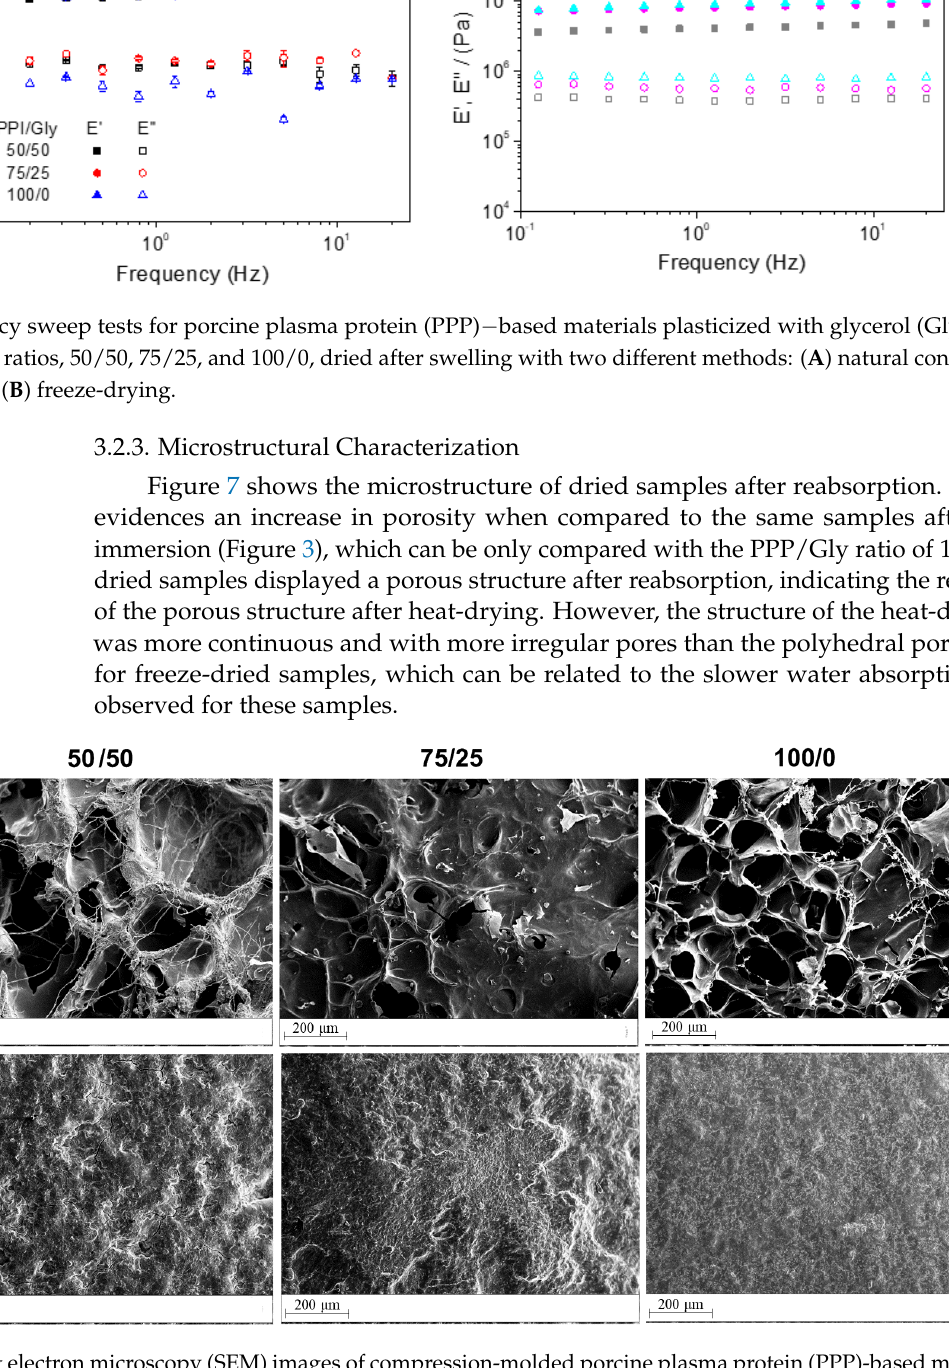
Figure 7. Scanning electron microscopy (SEM) images of compression-molded porcine plasma protein (PPP)-based materials plasticized with glycerol (Gly) with different PPP/Gly ratios, 50/50, 75/25, and 100/0, after the first water immersion, the drying stage (freeze-drying or thermal drying), the second water immersion, and the final freeze-drying.